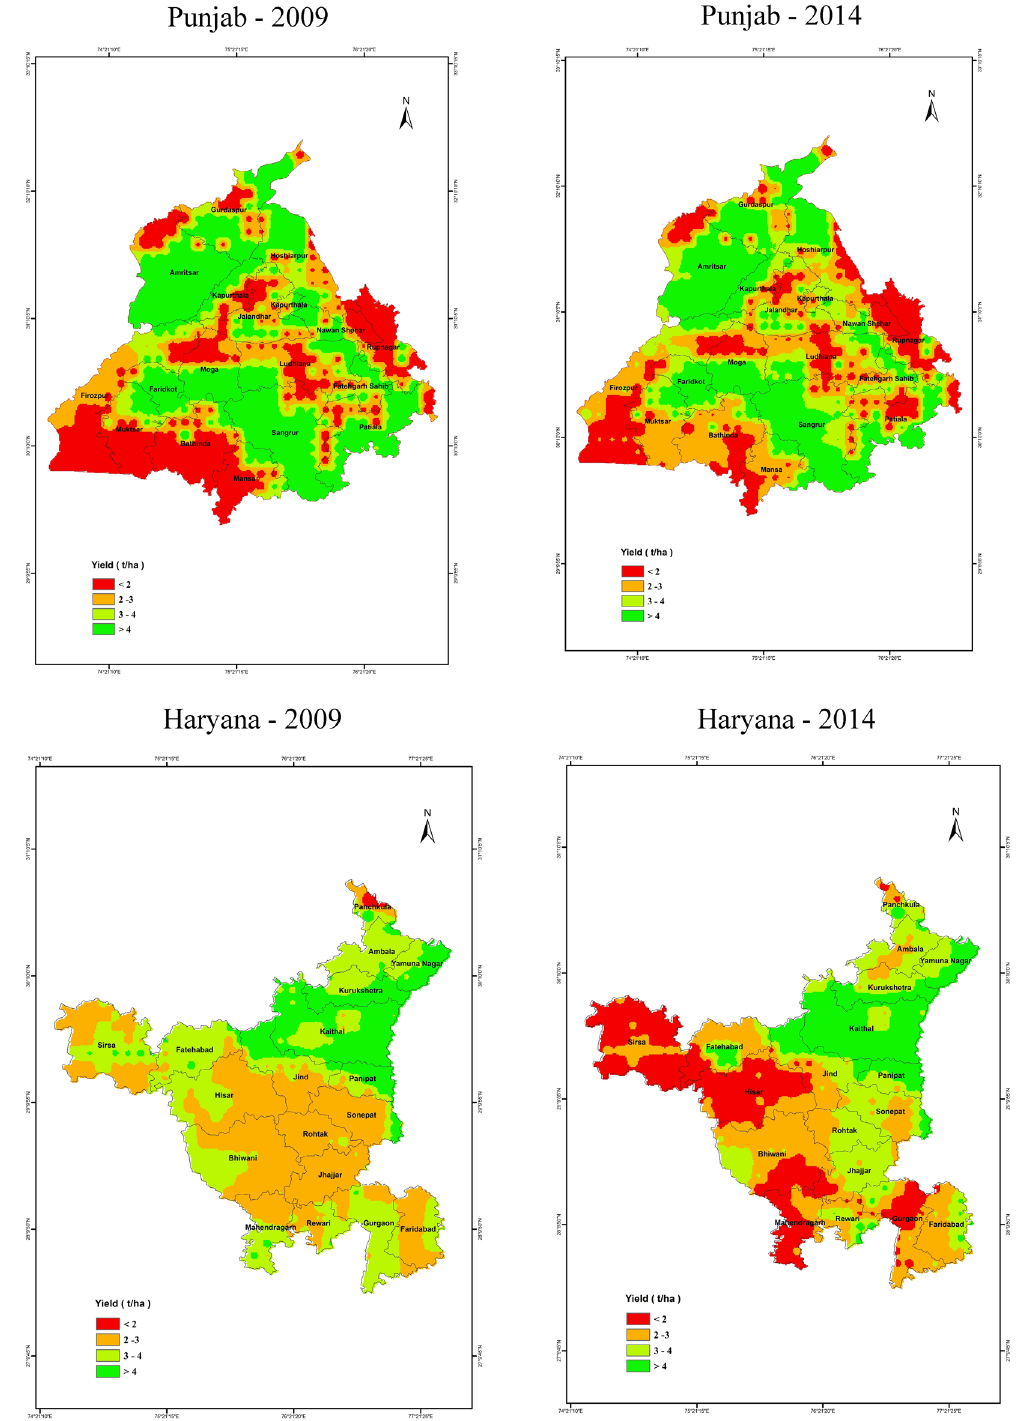
Figure 9. Spatial distribution of rice yield (t/ha) in the Punjab and Haryana regions for 2009 and 2014 years simulated by the DSSAT crop model (Map created at IIRS—https:// www. iirs. gov. in/ inhou selab orato